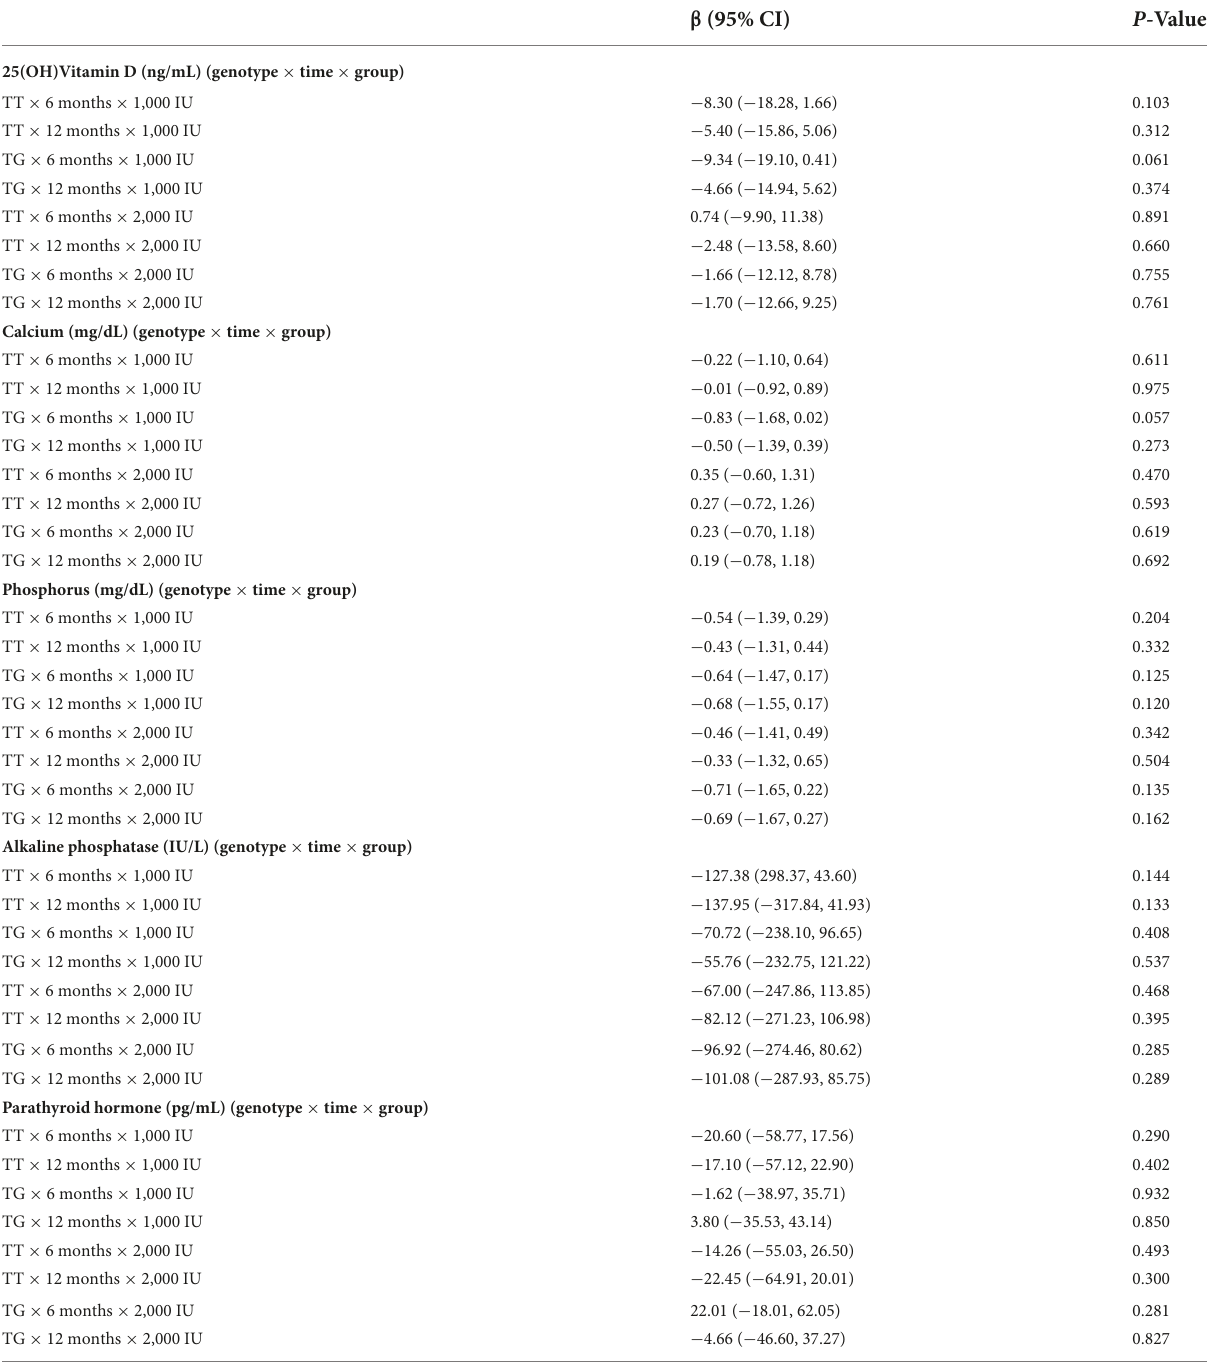
β (95% CI) P -Value